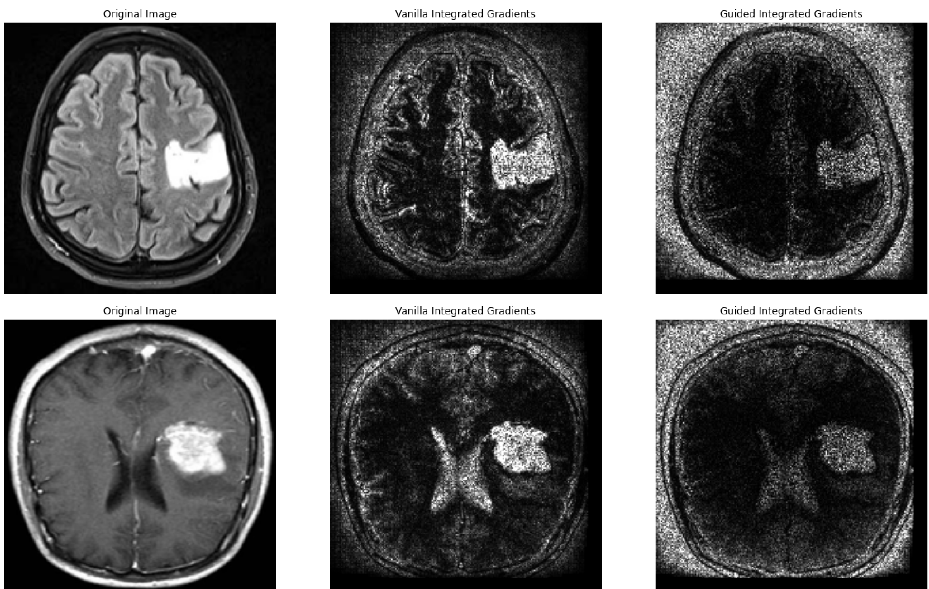
Figure 12. Guided integrated gradients results.